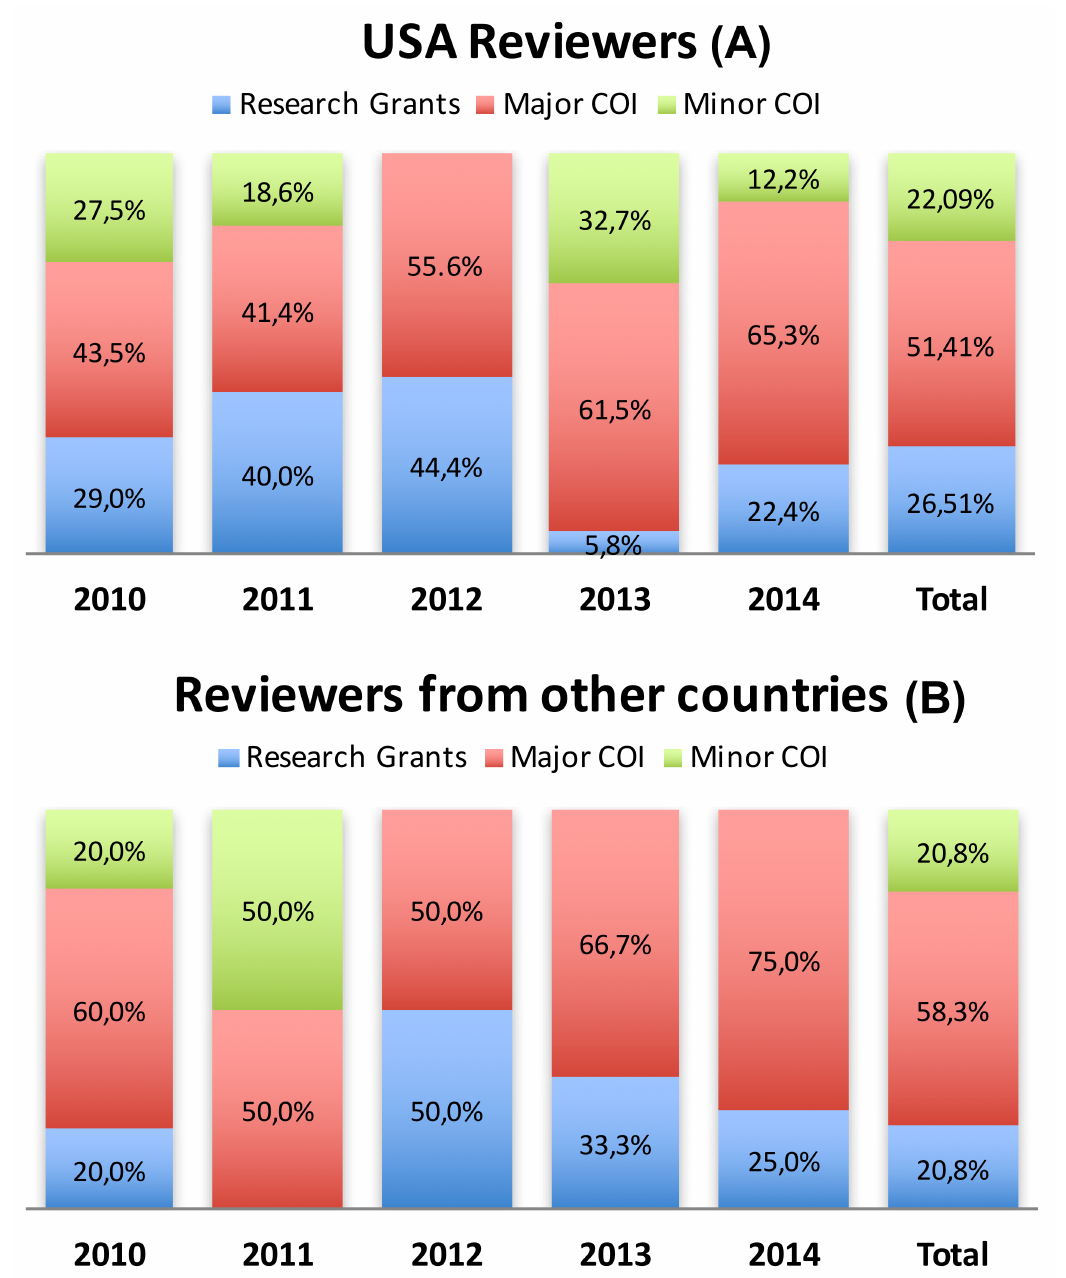
Fig 3. Type of COI disclosed by SRS and IMAST program review members along the period of study. (A) reviewers from the USA. (B) reviewers from other